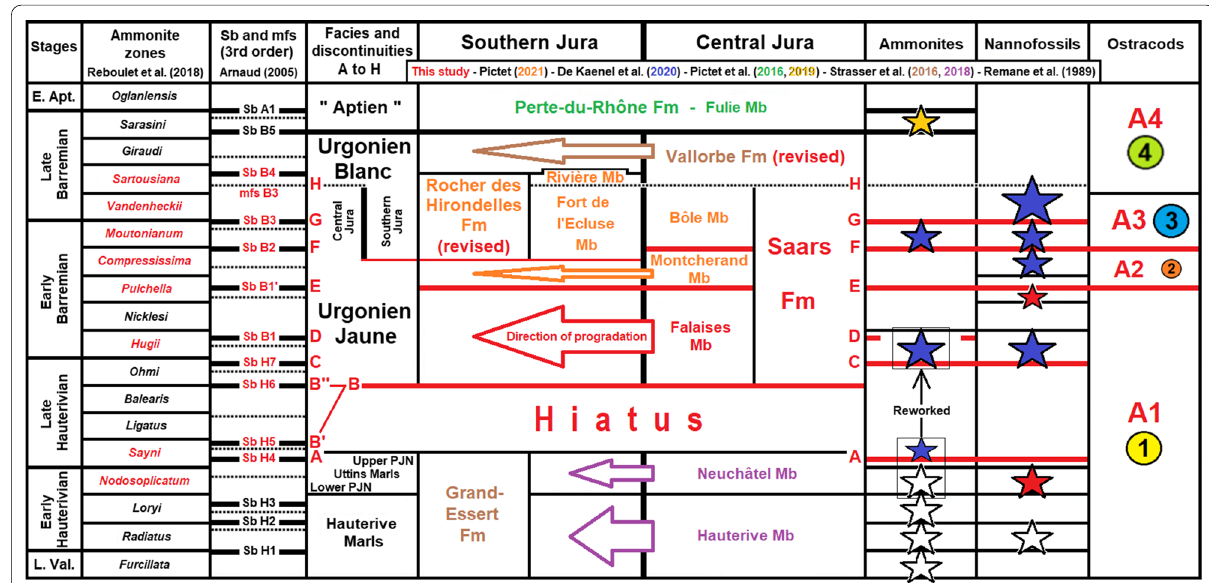
Fig. 11 Synthetic data of the Urgonian facies in the Swiss and French Jura Mountains: lithostratigraphic units, stratigraphical discontinuities and ages with currently available results about the collected ammonites, nannofossils and ostracods. The coloured large arrows indicate the general direction of progradation for the related lithostratigraphic